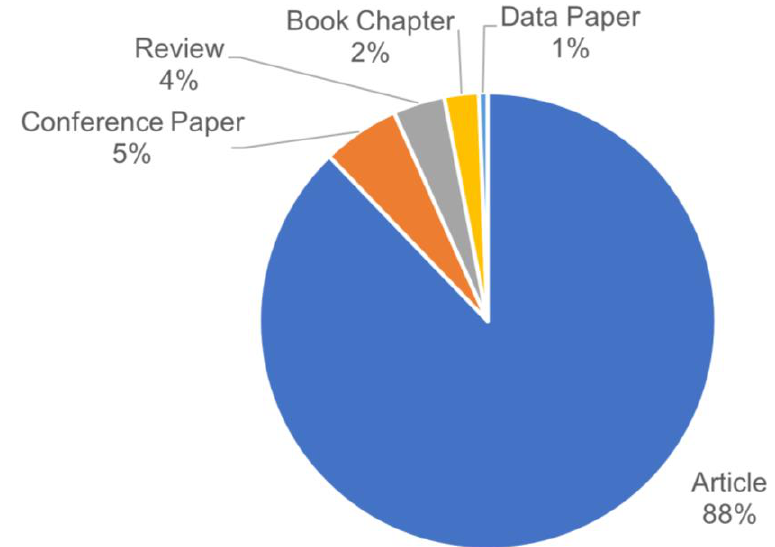
Figure 5. Distribution of publications according to document type, based on the SLR article selection performed in the Scopus database. Considered period: 2002–2022. Source: the authors.